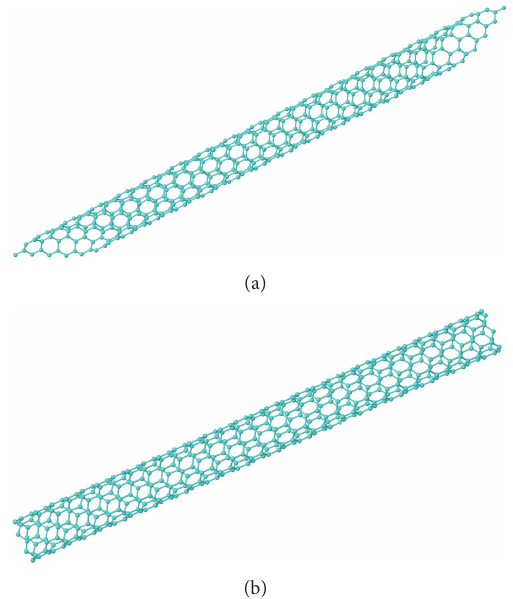
Figure 3: (color online) The appearance of the tube terminations for (a) [(7,7),𝑚 tr = 31] and (b) [(7, 0),𝑚 tr = 31] helical types of SWSiNTs with the same diameter ≈ 8.76